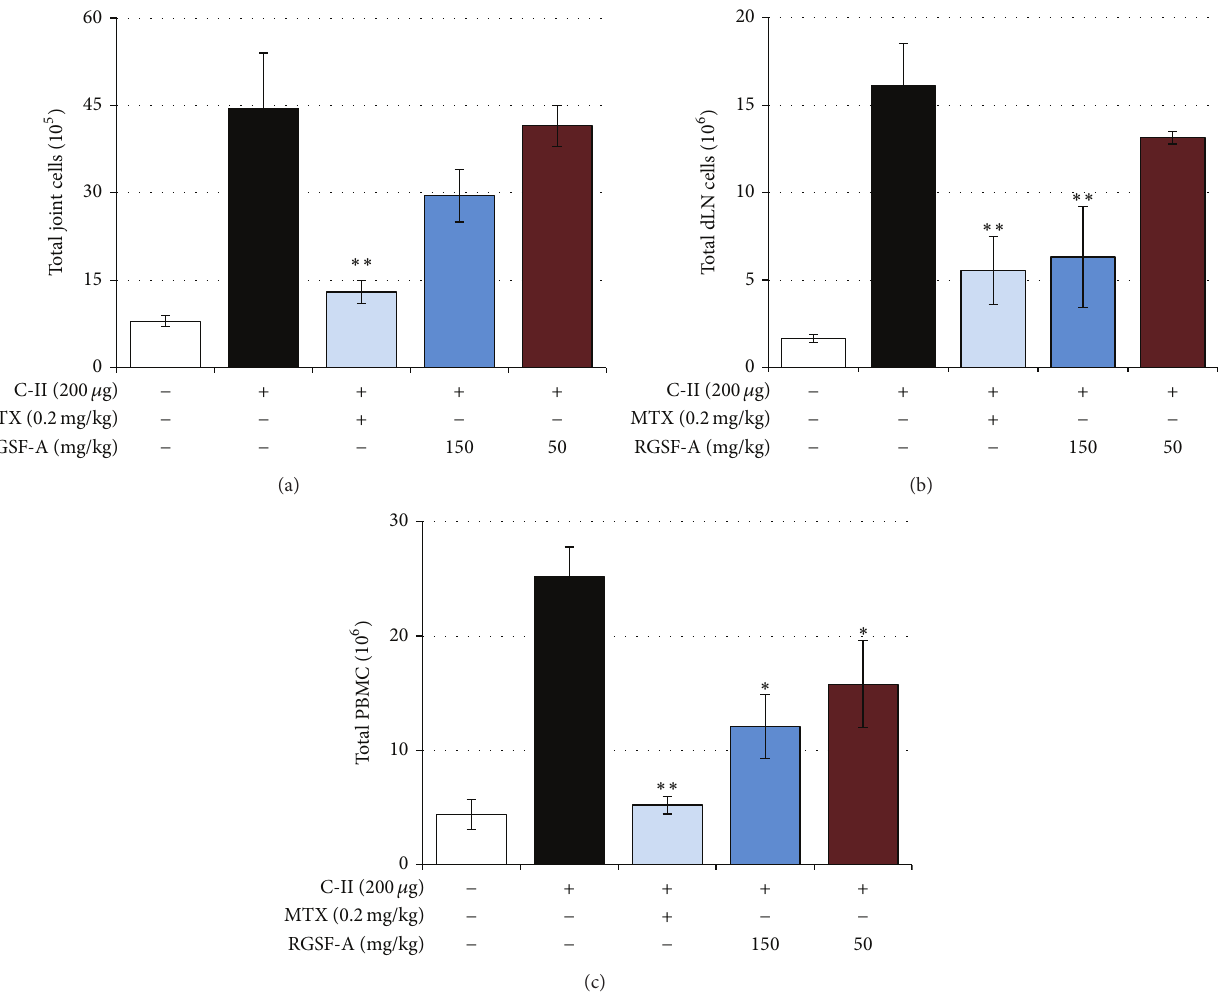
Figure 3: RGSF-A influences the total cell count of draining lymph nodes (dLN), joints, and peripheral circulation in CIA mice. Cells were counted manually using hemocytometer from synovial fluids (a), dLN (b), or peripheral blood mononuclear cells (PBMCs) (c) as indicated in Section 2. Bar graphs are summary of a triplicate count of 6 mice in each group. ∗ 𝑃 < 0.05 and ∗∗ 𝑃 < 0.01 as compared with vehicle